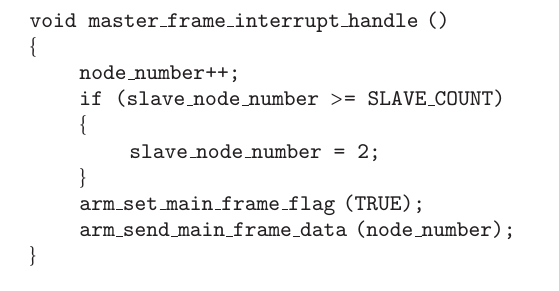
Algorithm 1: C code on the ARM system.